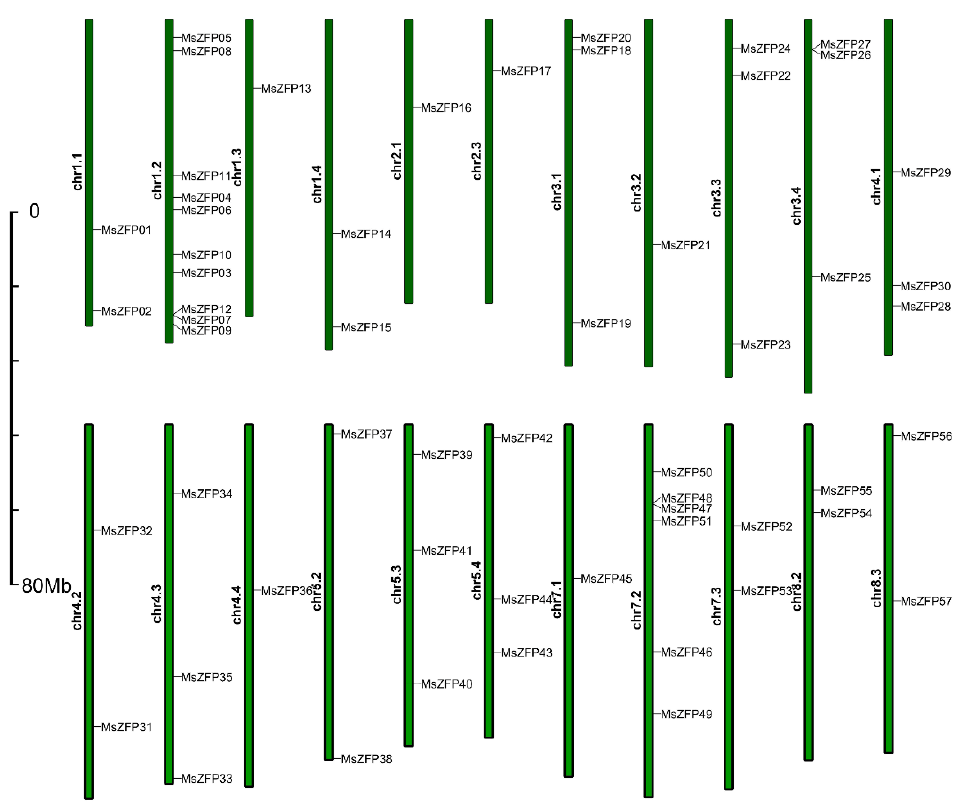
Figure 3. Genomic distributions of 58 MsZFP genes across the 32 alfalfa chromosomes. In the “ MsZFP gene distribution map” of 22 alfalfa chromosomes, the green bars represent each chromosome, and the black lines indicate the position of each MsZFP gene.